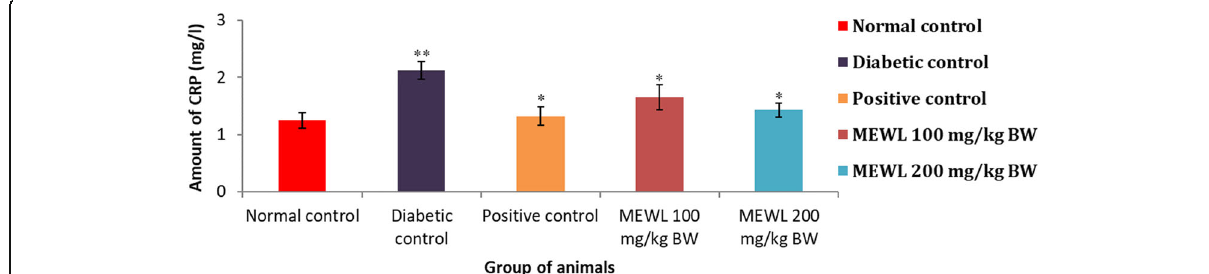
Fig. 6 Effect of MEWL on CRP levels in alloxan induced diabetic mice. All data are expressed as mean ± SD (n; number of mice = 5). Here “ ** ” indicates p < 0.01 vs normal control mice and “ * ” indicates p < 0.01 vs diabetic control